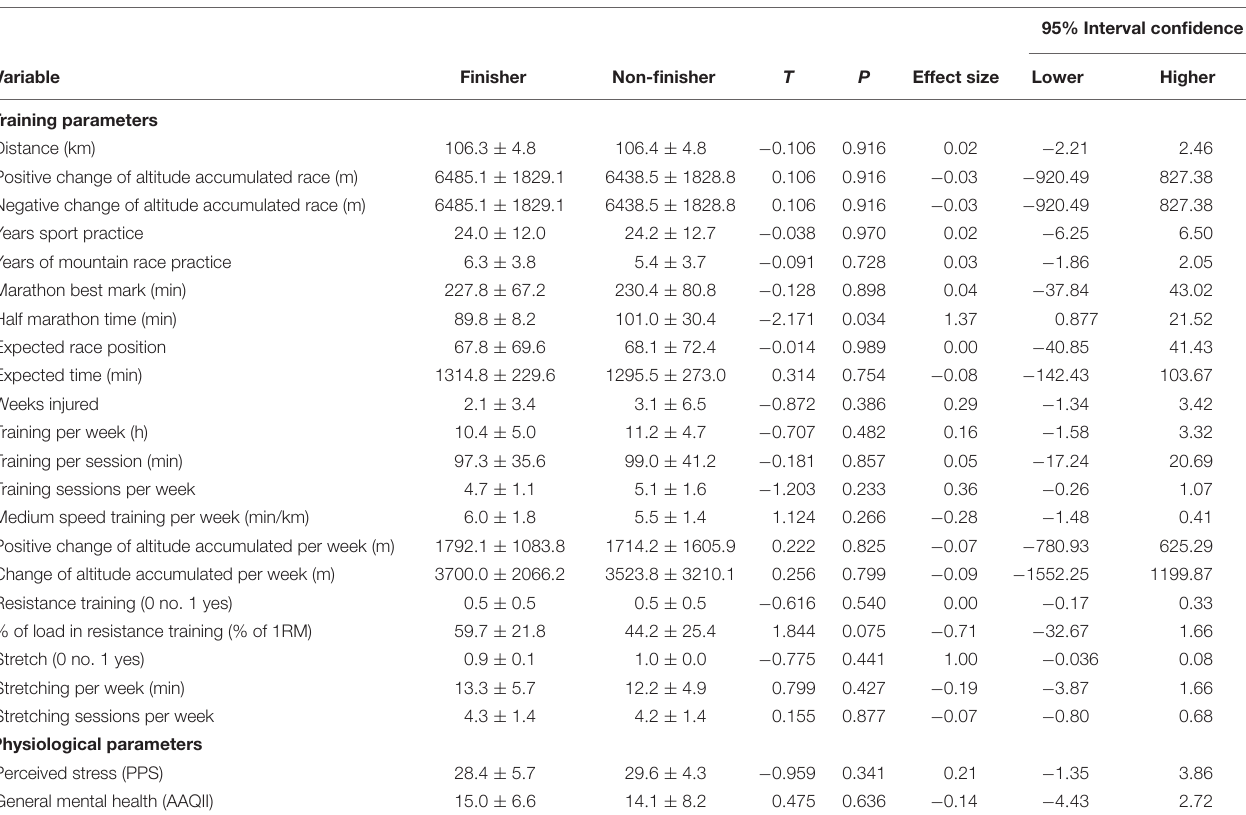
TABLE 2 | Differences between mountain ultra-endurance finishers and non-finishers in training and psychological